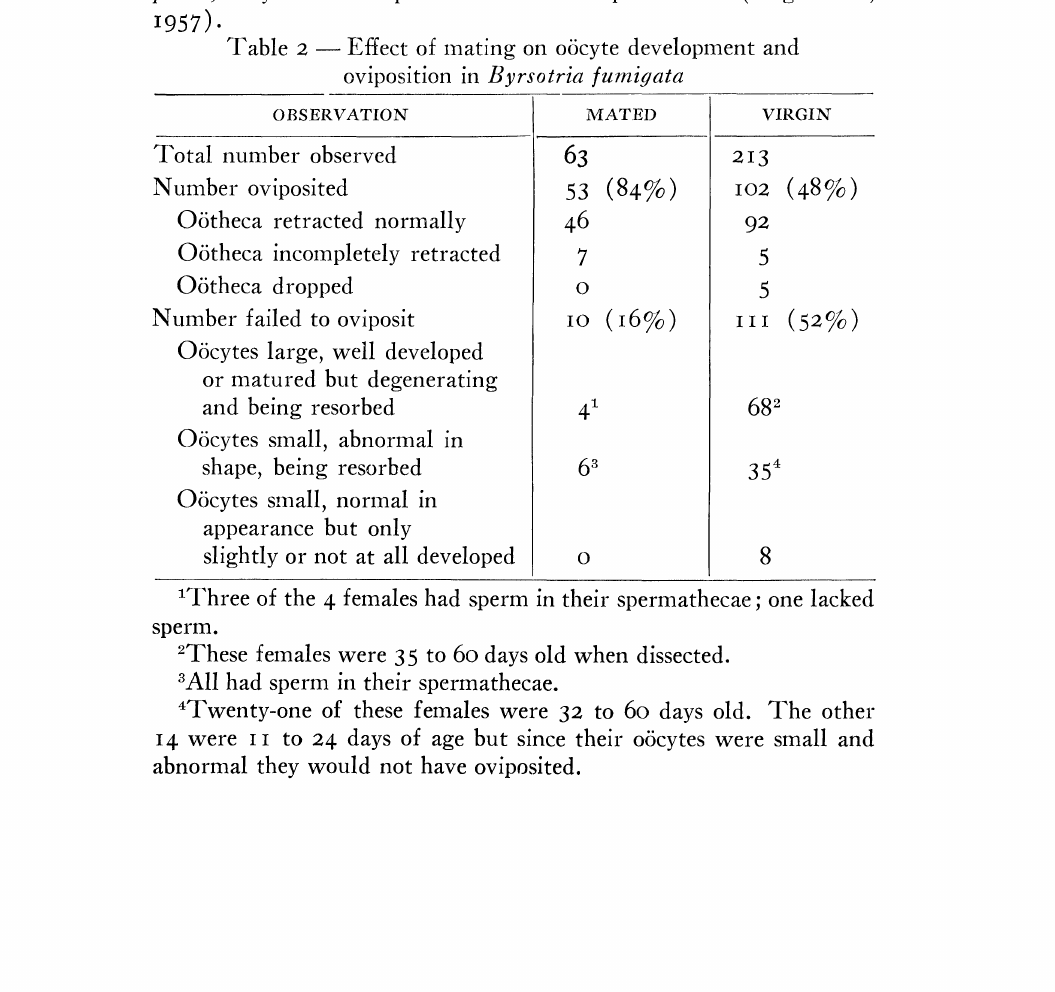
Table 2- Effect of mating on o6cyte development and oviposition in Byrsotria [umiyata